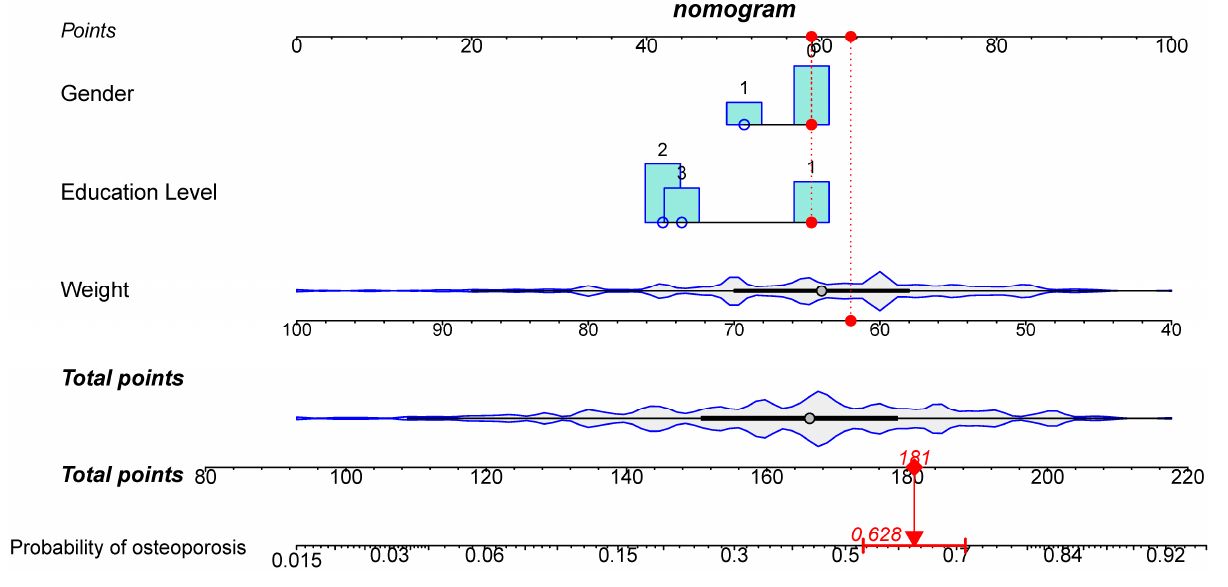
Figure 3. Nomogram for predicting osteoporosis based on the training group. Three clinical characteristics—gender, education level, and weight—were incorporated into the nomogram prediction model. The first row was the Point marked with a scale. Rows 2, 3, and 4 were the 3 clinical characteristics, which were marked by scales, respectively. Rows 5 and 6 were Total points marked with scales. Row 7 was the predicted probability of osteoporosis marked with a scale. The distribution of each clinical characteristic was also shown. Each clinical characteristic was marked with a red dot and a vertical line was drawn according to the specific situation of a particular clinical subject here. The vertical line intersected with the 1st line; this Point was recorded, and each Point was summed to obtain the Total point. Then, the vertical line was made at this Total point and the vertical line intersected with the 7th row. This probability here is the probability of osteoporosis of this one clinical subject. In this graph, a female clinical subject with an education level of 1 and a weight of 62 kg was used as an example. According to this nomogram clinical prediction model, the Total point of osteoporosis for this clinical subject was 181, corresponding to a probability of 0.628. The “1”, “2”, and “3” for “Education Level” stand for “Junior high school”, “High school”, and “Undergraduate”, respectively.